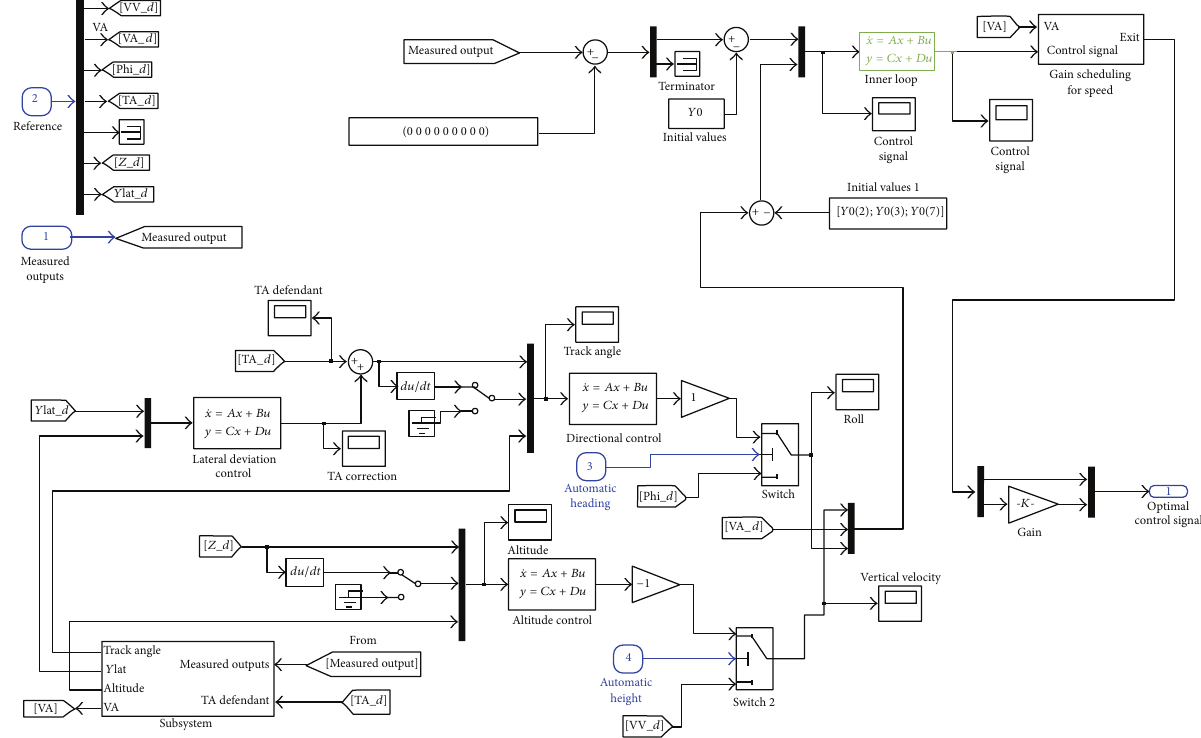
Figure 3: Framework to design the 𝐻 ∞